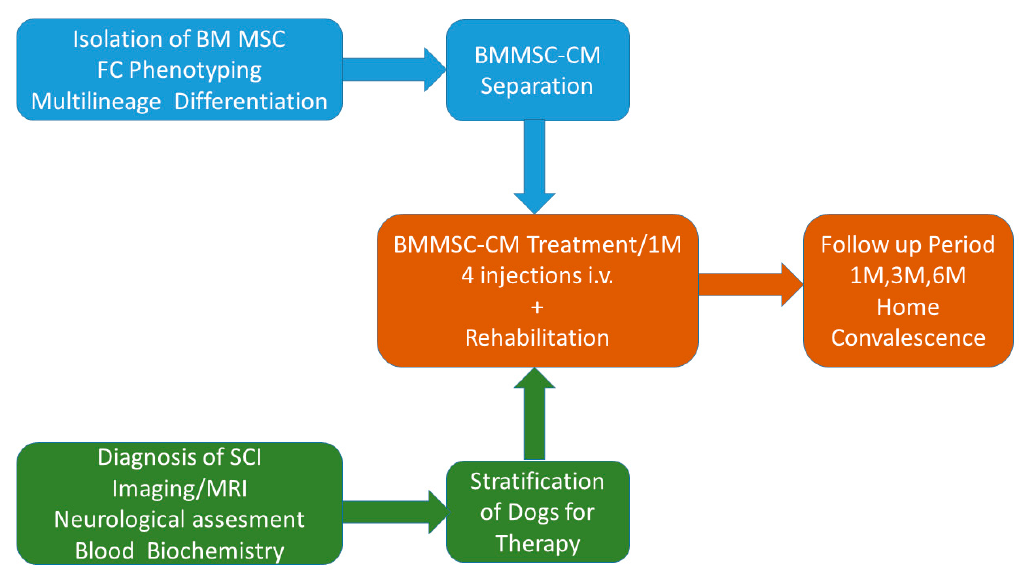
Figure 6. Design of treatment protocol. Chronological procedures performed before, during and after bone marrow tissue-derived MSC conditioned medium (BMMSC CM) treatment. FC (flow cytometry), M (month), i.v. (intravenous), SCI (spinal cord injury), MRI (magnetic resonance imaging).